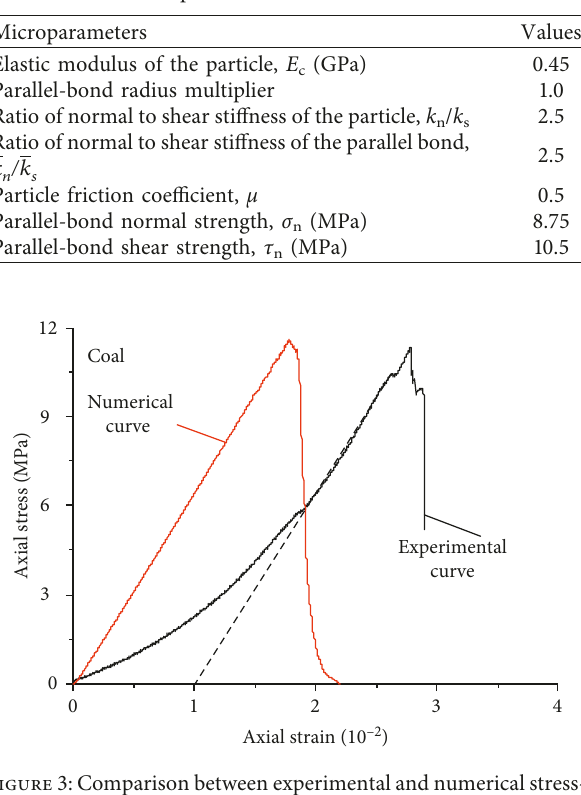
Table 2: Microparameters used in the PFC2D model.